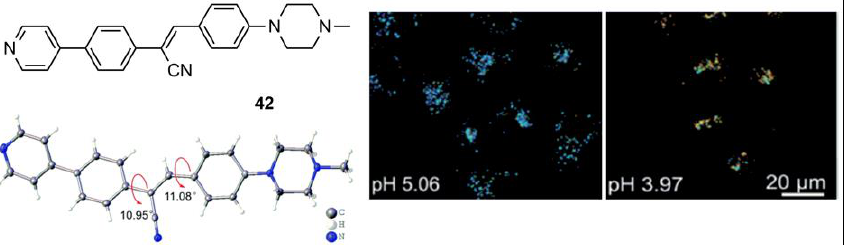
Figure 43. Structure and the single crystal structure of probe 42 . The ratiometric images of the lysosomal pH distribution of HeLa cells without stimulants (left image) and stimulated with 10 mM acetic acid incubated for 8 min at 37 ◦ C (right image). Adapted with permission from [133]. Copyright (2020) The Royal Society of